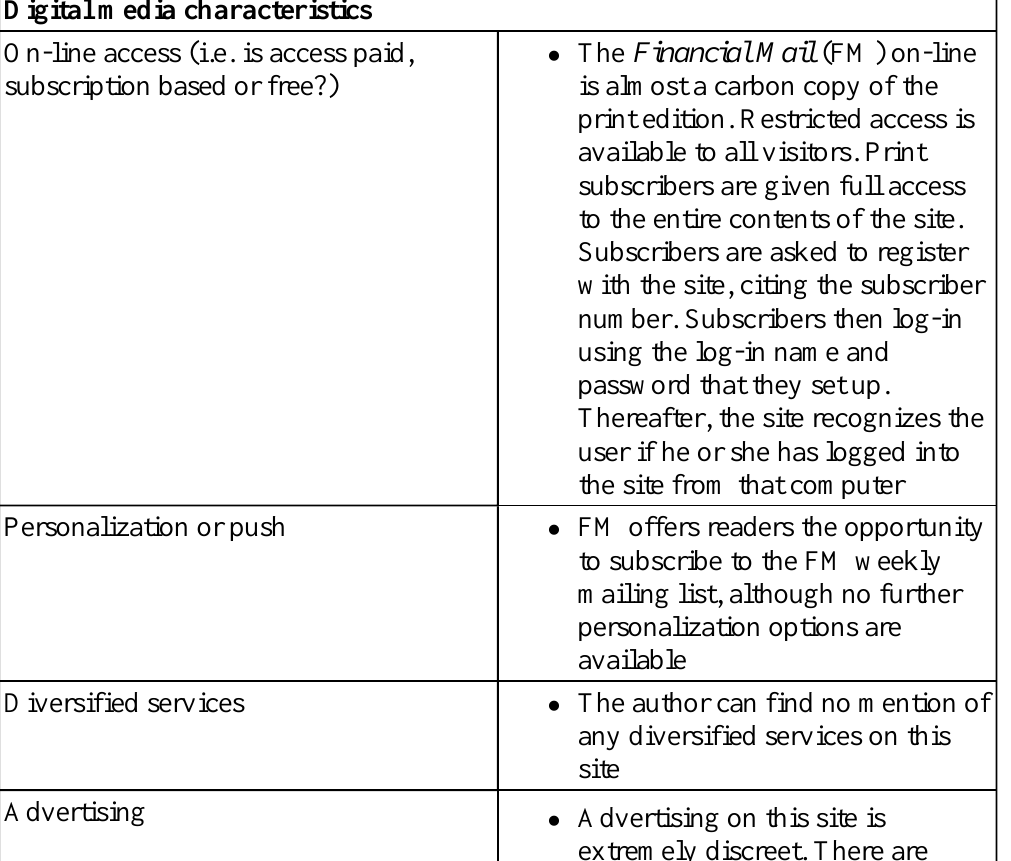
Table 8 Summary of the compliance of the Financial Mail on-line to three evaluation criteria